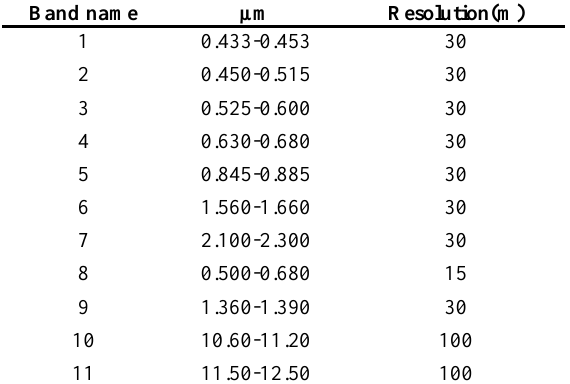
Table 2. OLI Spectral Bands